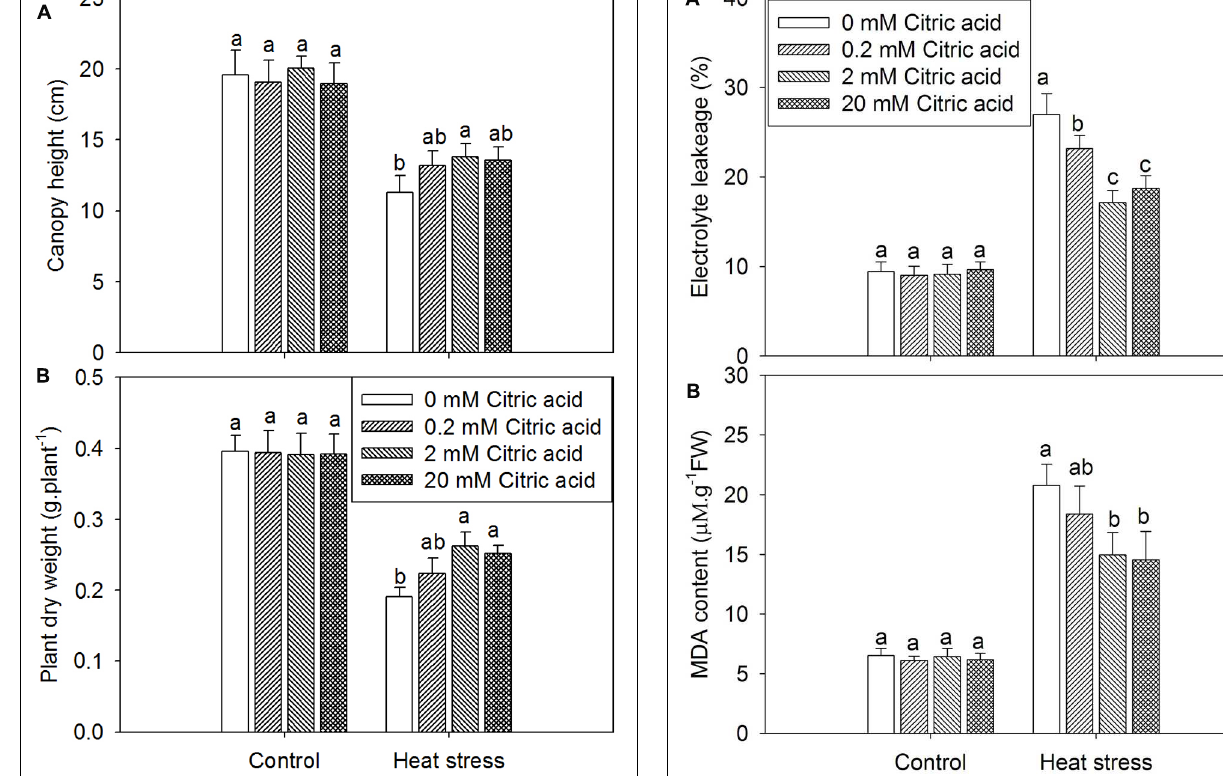
(PSII, F v/ F m) was measured by analysis of Chl